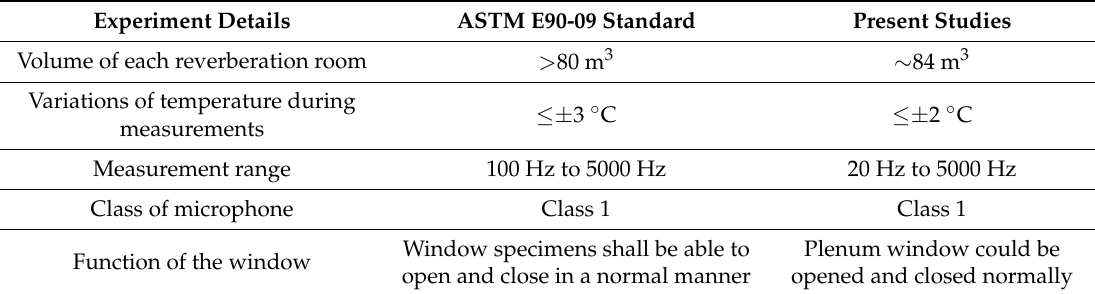
Table 3. For experiment I (without jagged flap), plenum window with perforated thin box manages